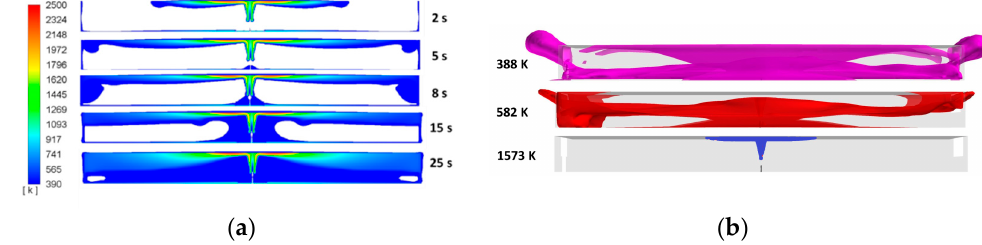
Figure 5. ( a ) Temperature contours along the central plane of the covered car park for case 1. ( b ) Side view iso-surfaces showing pain limit (top), fatality limit (middle) and flame temperature (bottom) for case 1 (TPRD = 3.34 mm, constant upward release from distance 2.1 m to the ceiling, no car body) at time 20 s.